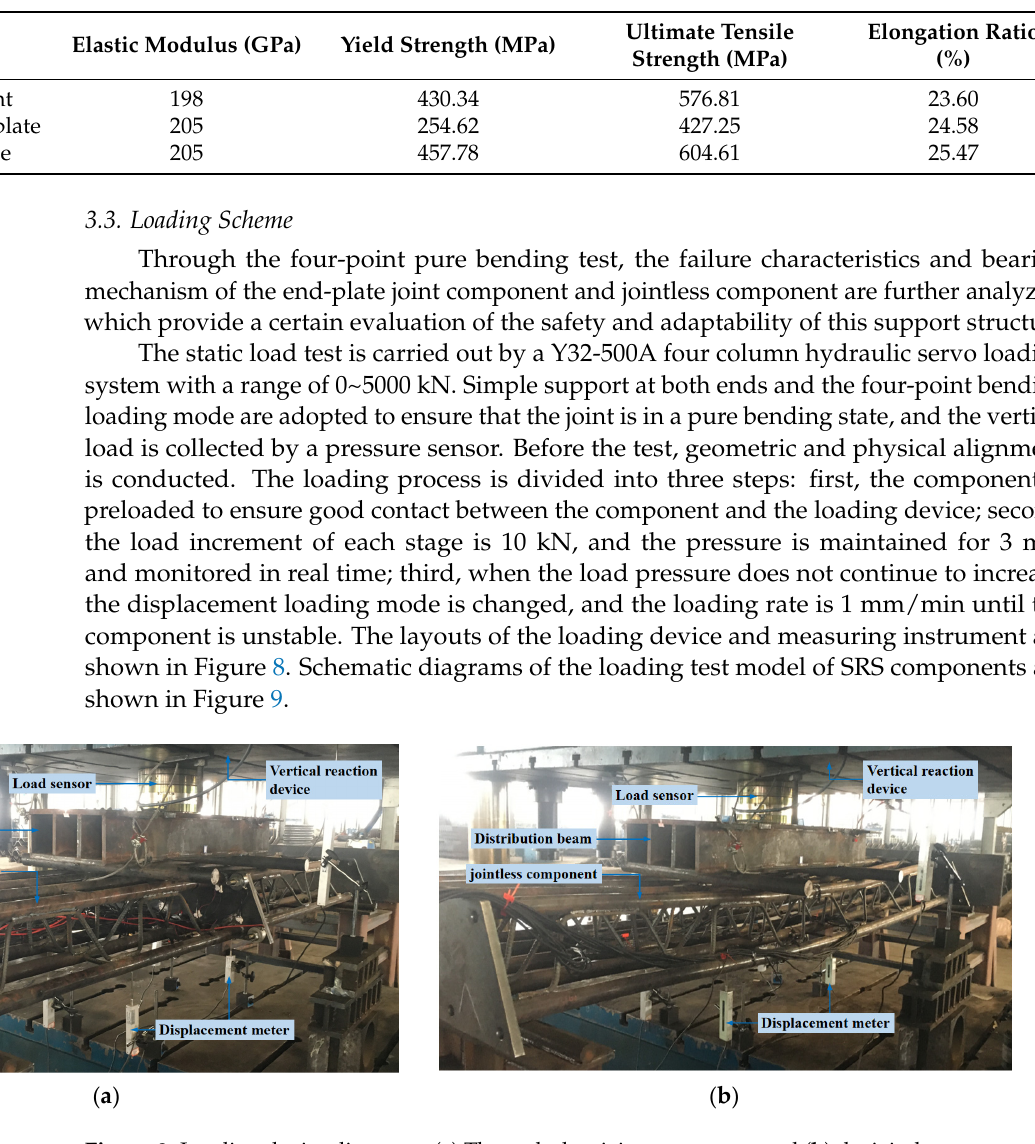
Figure 8. Loading device diagrams. ( a ) The end-plate joint component and ( b ) the jointless compo- nent.